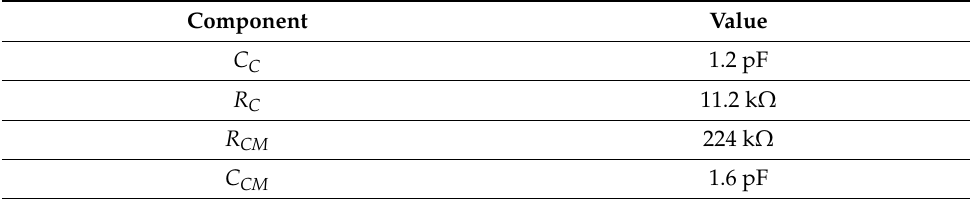
Table 4. Values of the passive components in the current buffer.